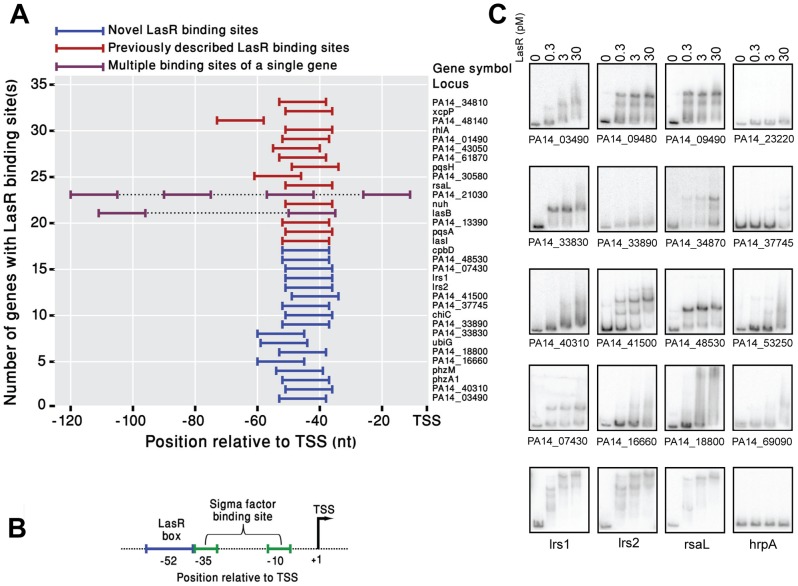
Identification of new LasR binding sites.(A) Location of LasR boxes of genes relative to the TSSs. Most LasR binding sites (LasR box) are localized at 51–52 nt upstream to the TSS of the genes. The binding site is shown as a line upstream to the TSS (blue, red, and purple; novel binding sites, previously known binding sites, and genes with multiple binding sites, respectively). (B) Positioning of the LasR box (blue line) is immediately upstream to the sigma factor binding site (green line). Black arrow represents the TSS. (C) EMSA of DNA fragments from predicted LasR-regulated genes. The concentrations of purified LasR used in each assay are shown above the reactions. DNA fragments from the promoter region of the rsaL and an internal fragment from the hrpA gene were used as positive and negative controls, respectively.